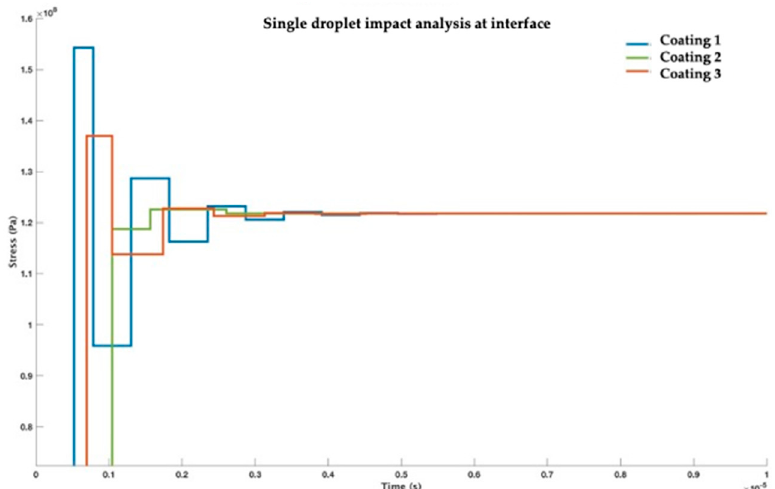
Figure 7. Variation of stress at coating-substrate interface for three different top coating LEP material candidates for the same substrate. It can be observed the capability to avoid peak values with the appropriate selection of the material impedances.